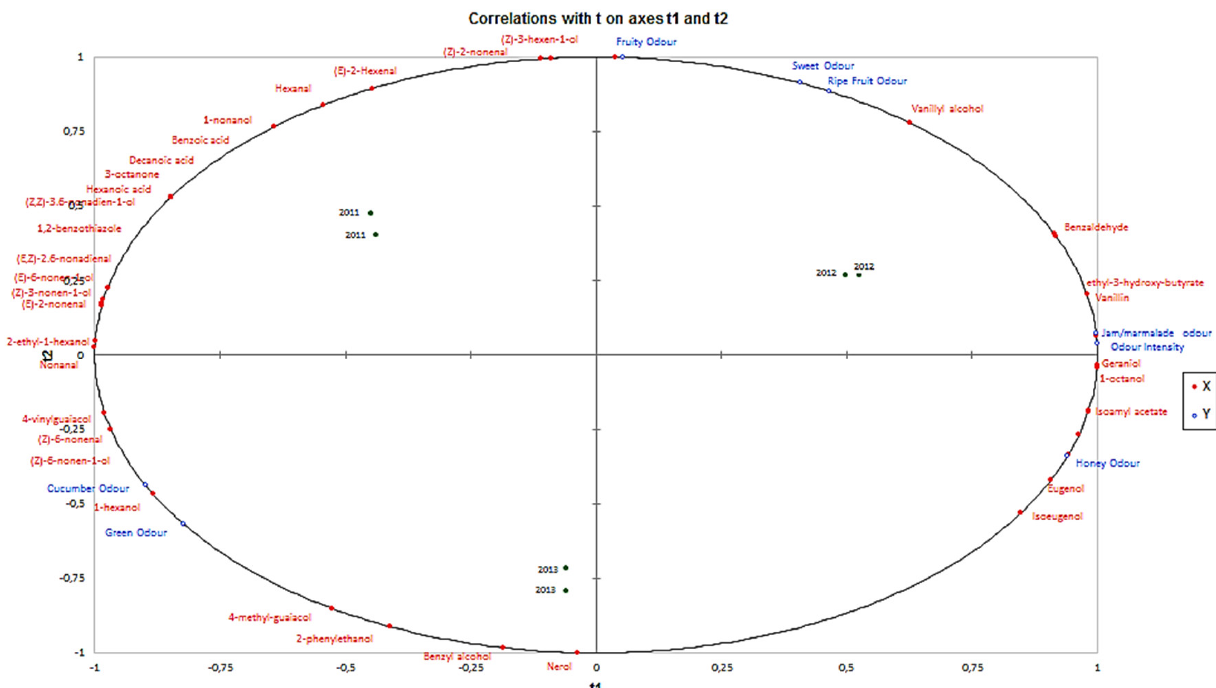
Figure 2. PLS loading for t1 y t2 for sensory attributes (Y variables) and volatile compounds of La Mancha Trujillo melons (X variables) from three harvest considered .